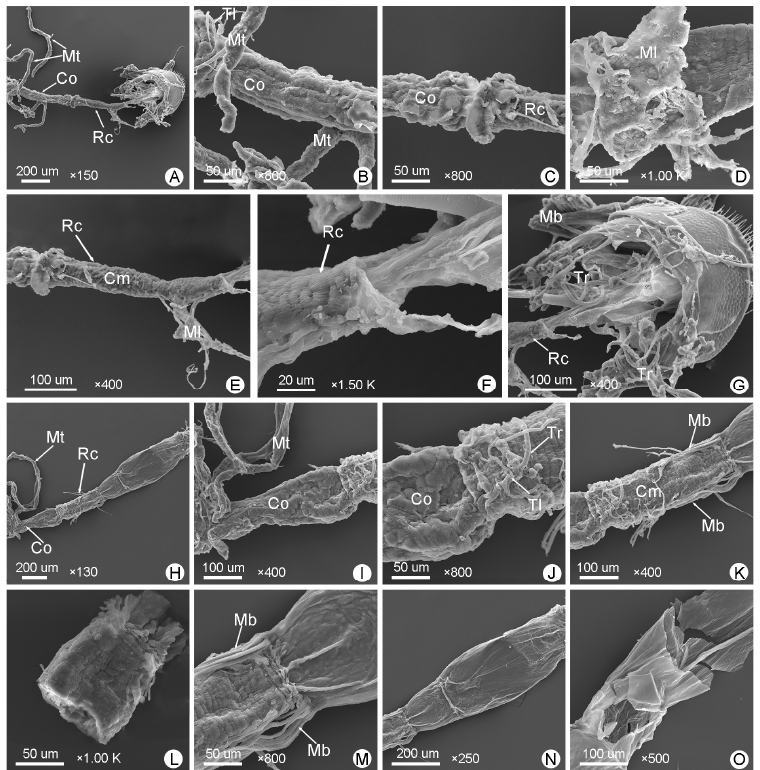
Figure 8. The hindguts and the associated membranous structure of M . ( O .) chinensis (males ( A – G ), fe- males ( H – O )): ( A , H ) general view of colon (Co) and rectum (Rc); ( B , I ) general view of colon; ( C , J ) junction of colon and rectum; ( D ) the muscle layer (Ml) covering the rectum; ( E , K ) circular muscles (Cm) sur- rounding the rectum; ( F , M ) posterior rectum; ( L ) cross-section of rectum; ( G , N , O ) the membranous struc- ture. Mb: muscle bundle, Mt: Malpighian tubule, Tl: tracheole, Tr: